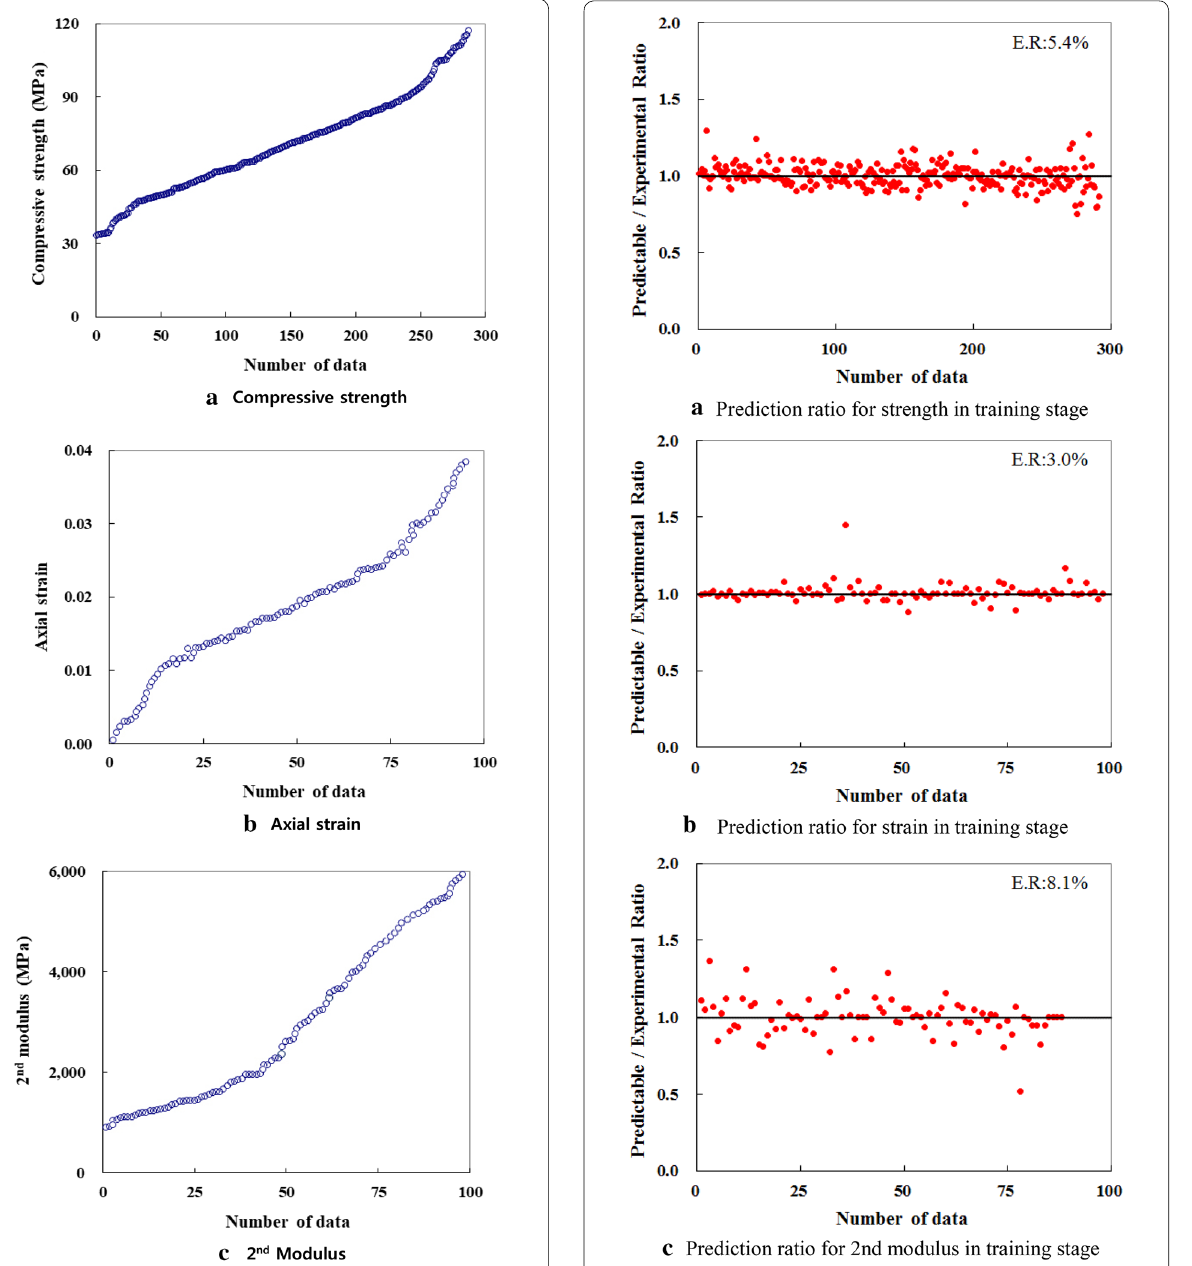
Fig. 4 Range of experimental values used as learning data. Fig. 5 Prediction ratio in training